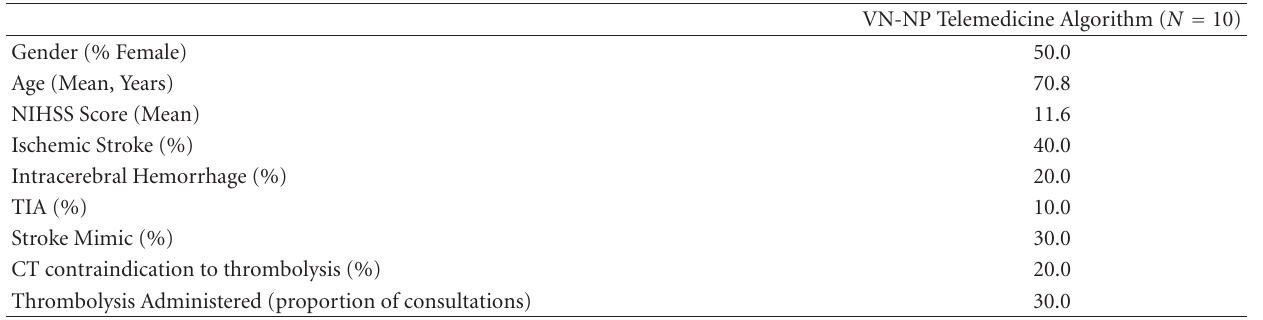
Table 1: Demographic information, diagnoses, and thrombolysis eligibility.